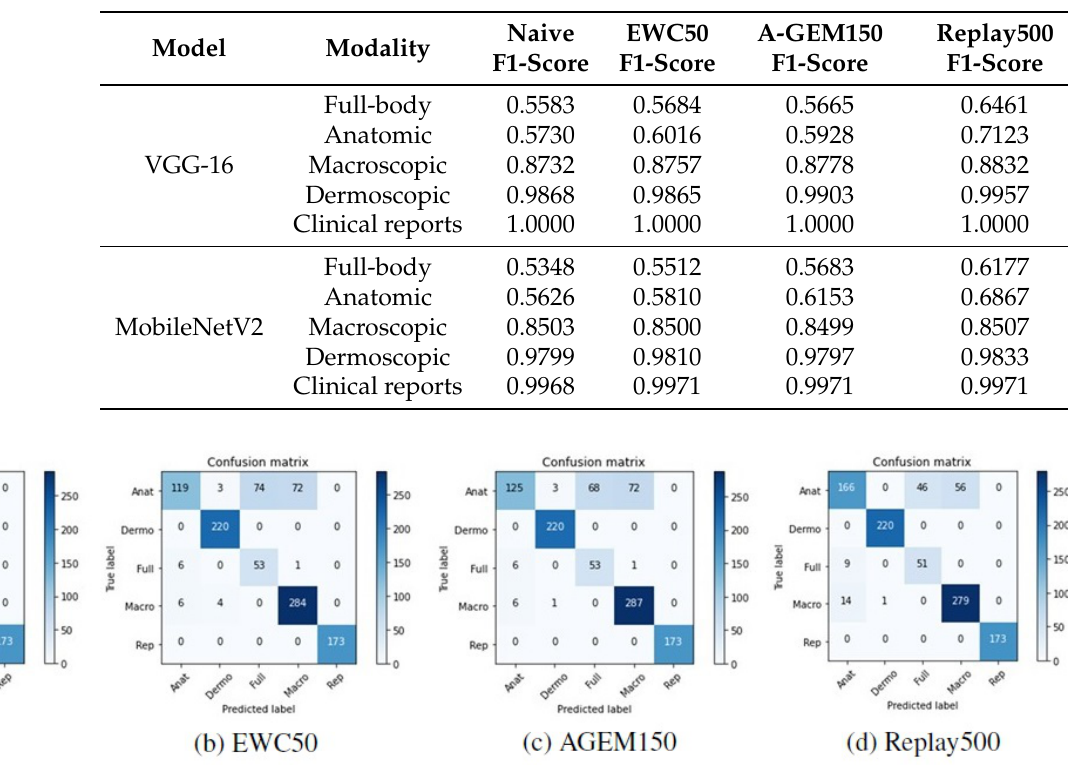
Figure 5. Confusion matrices of Task A test images after the training of Task B with the VGG-16